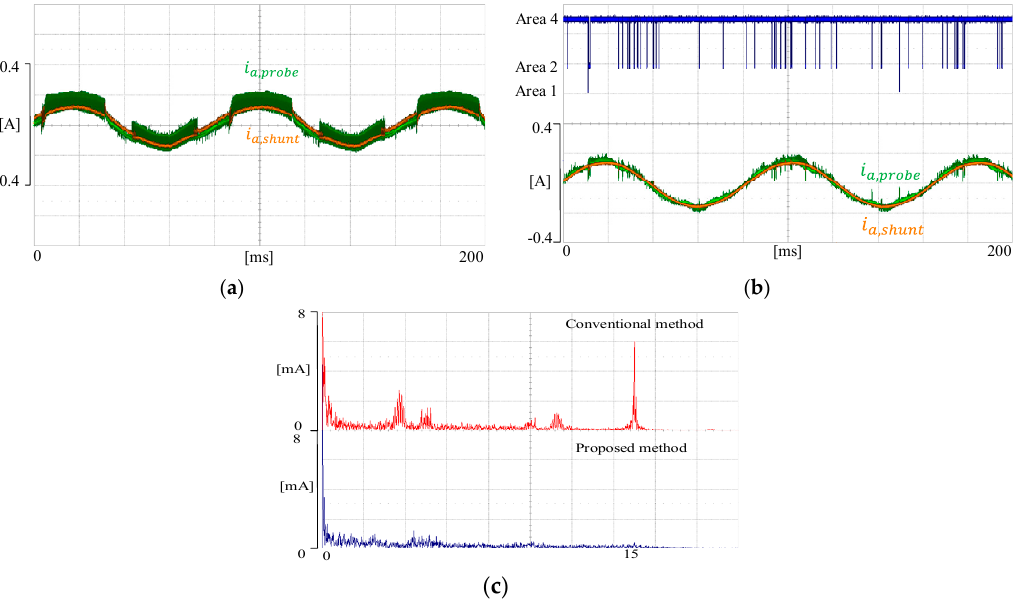
Figure 17. The phase current sampled through shunt resistor when the motor is operated at 30 rpm: ( a ) Conventional voltage injection method; ( b ) proposed intermittent PWM shift method; ( c ) FFT result of the phase current.